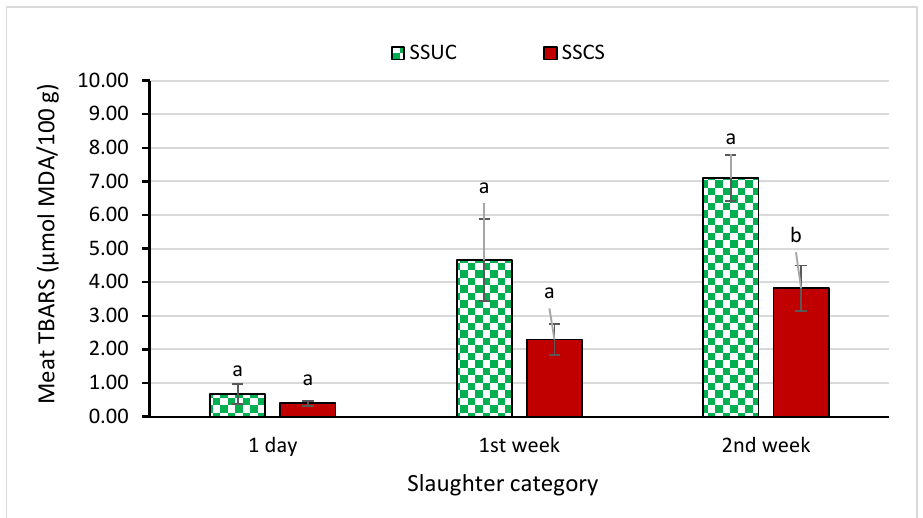
Figure 3. Effect of slaughtering with or without state of consciousness on Longissimus dorsi muscle’s oxidative stability (TBARS value) in Korean Hanwoo Finishing Cattle during storage at 4 °C. a, b Means in the same bar with different superscript letters are significantly different at p < 0.05.